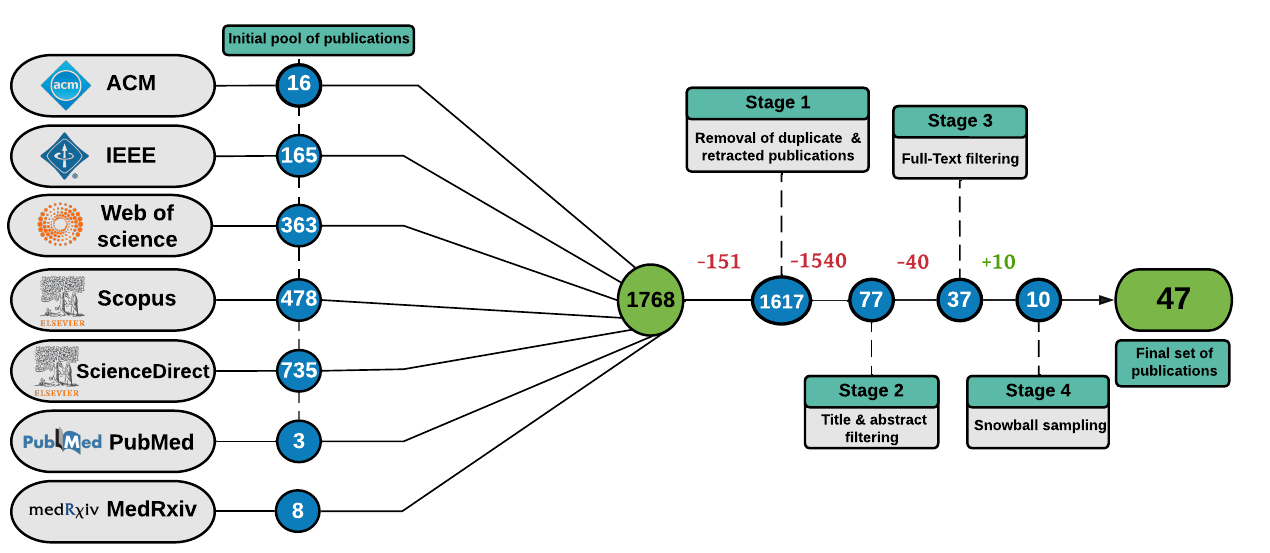
Figure 1. Overview of the number of publications resulting from the filtering